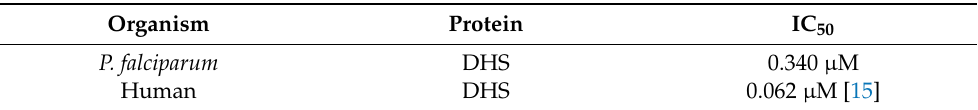
Figure 4. Dose–response curve of the allosteric inhibitor showing the log doses (x axis) versus % inhibition (y axis) in non-linear regression. Table 2. IC 50 determination for 6-bromo - N - (1 H -indol-4yl)-1-benzothiophene-2-carboxamide in P. falciparum and human.